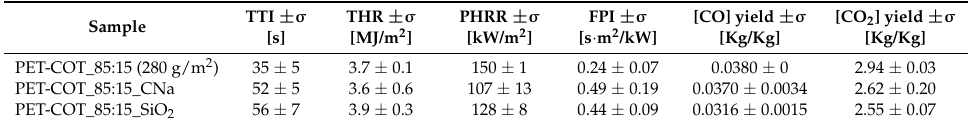
Table 5. Combustion data of untreated and NP-treated PET-COT_85:15 by cone calorimetry (35 kW/m 2 ) [22].